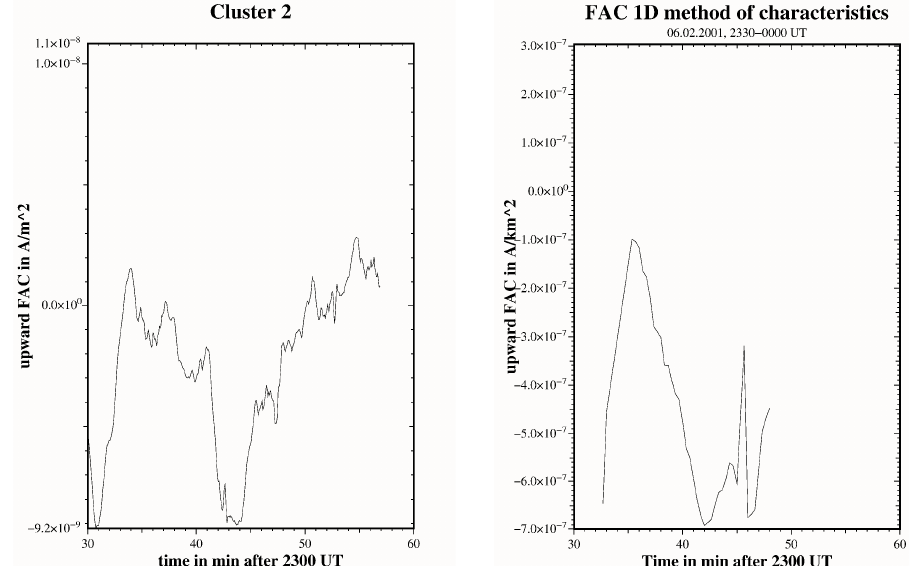
Fig. 8. Comparison of the FAC as calculated from Cluster spacecraft 2 (left panel), and the results of the 1-D method of characteristics along the ionospheric magnetic footprints of the spacecraft (right panel); in Am − 2 , positive values correspond to upward